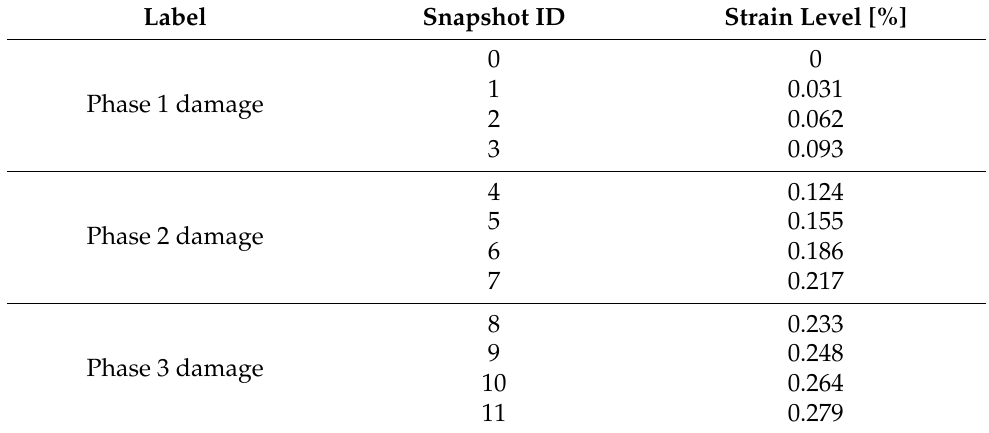
Table 2. List of mesostructure snapshot ids and the corresponding labels and strain levels.